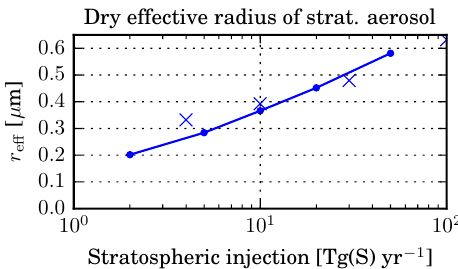
Figure 8. Global mean dry effective radius (in µm) of the strato- spheric sulfate aerosol as a function of sulfur injection rate (Tg S yr − 1 ). The solid lines show the results from the x _TGS experiments using LMDZ-S3A, while the crosses show results from a previous study by Niemeier and Timmreck (2015).